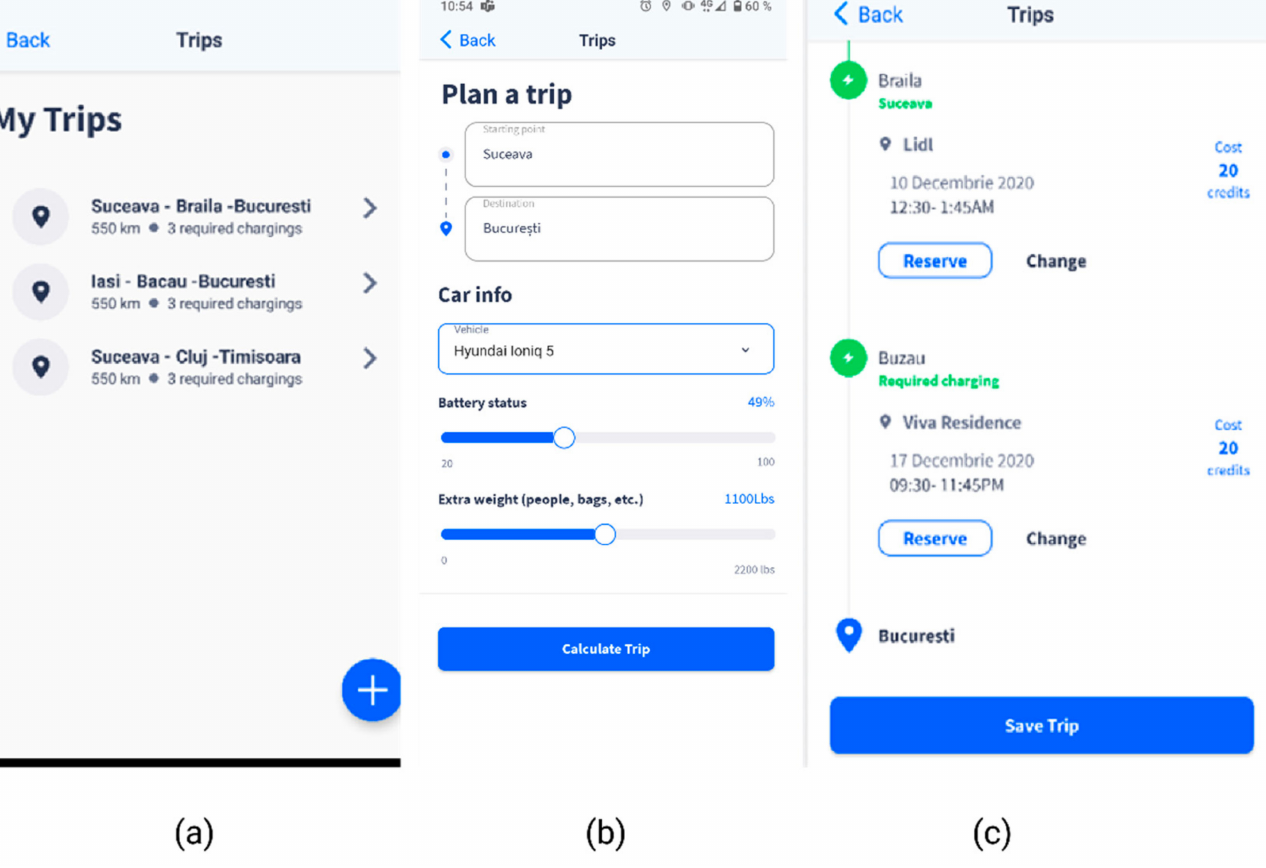
Figure 7. Smart EVC—Plan a trip section. ( a ) EV trips list; ( b ) Plan a trip feature, with details on the battery level and extra weight, based on which the necessary recharging operations are calculated; ( c ) Proposed charging stations along the route, with reservation